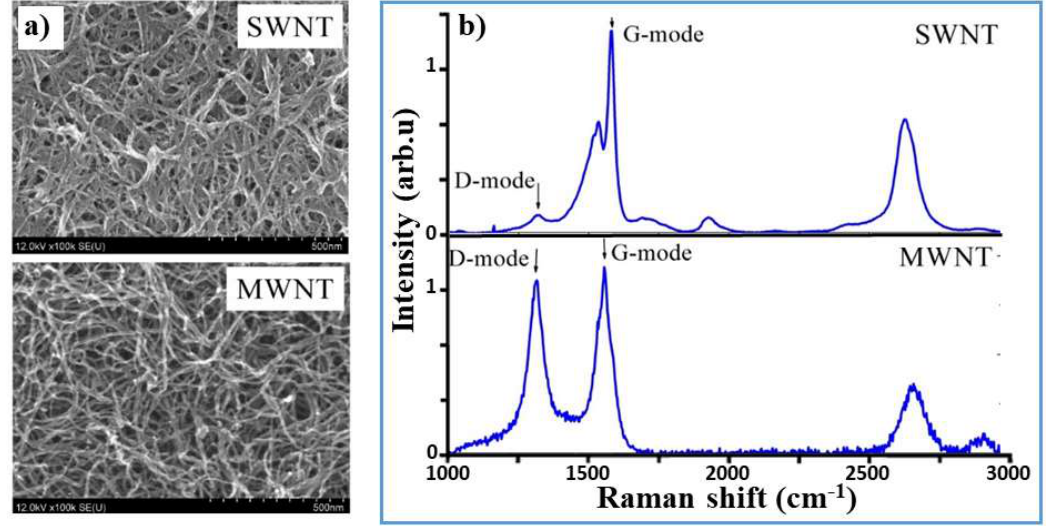
Figure 3. Structural characterization of the CNTs: ( a ) SEM micrographs of the SWNT and MWNT films; ( b ) Raman spectroscopy results. films; ( b ) Raman spectroscopy